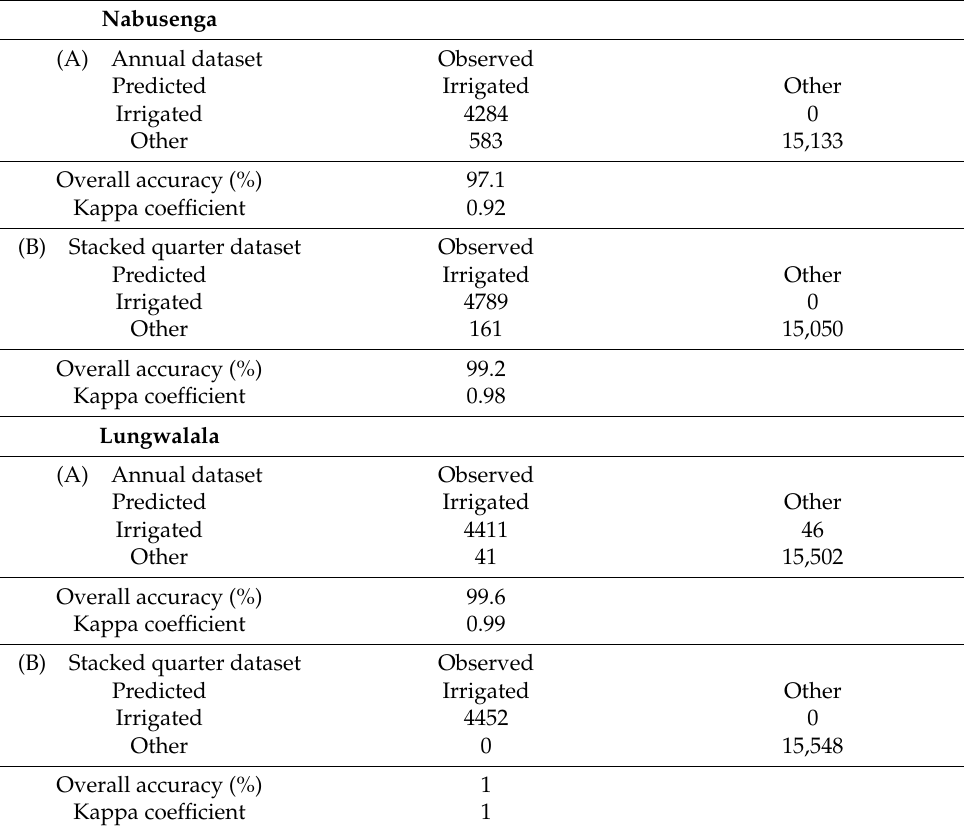
Table 4. Cont. Nabusenga